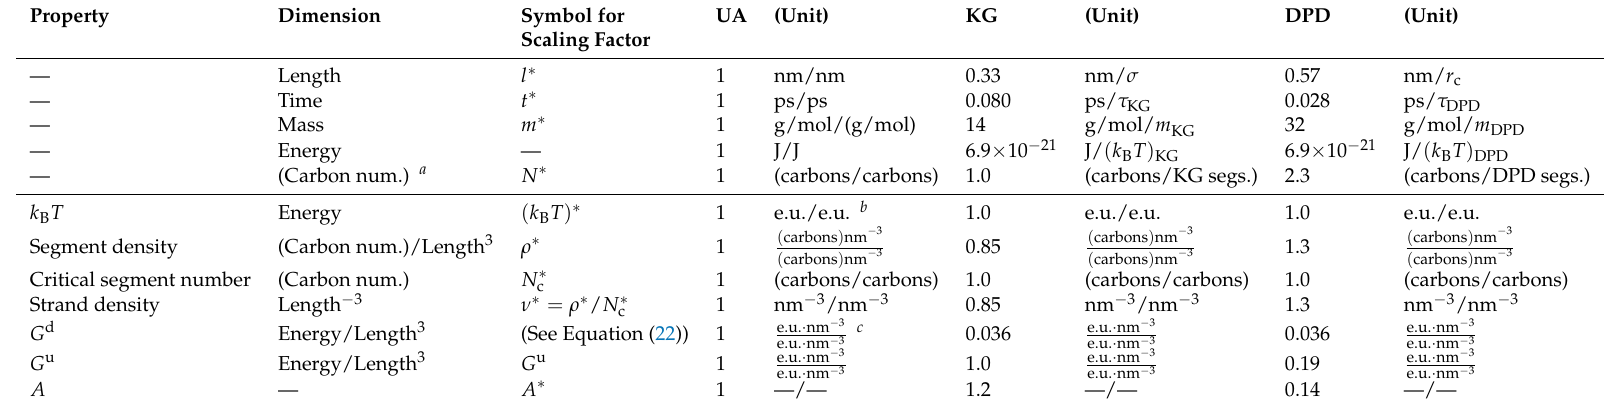
Table 1. Scaling factors of the UA model of PE melts, KG model, and DPD with slip-spring model. a “Carbon num.” becomes the “dimension” of segment number.